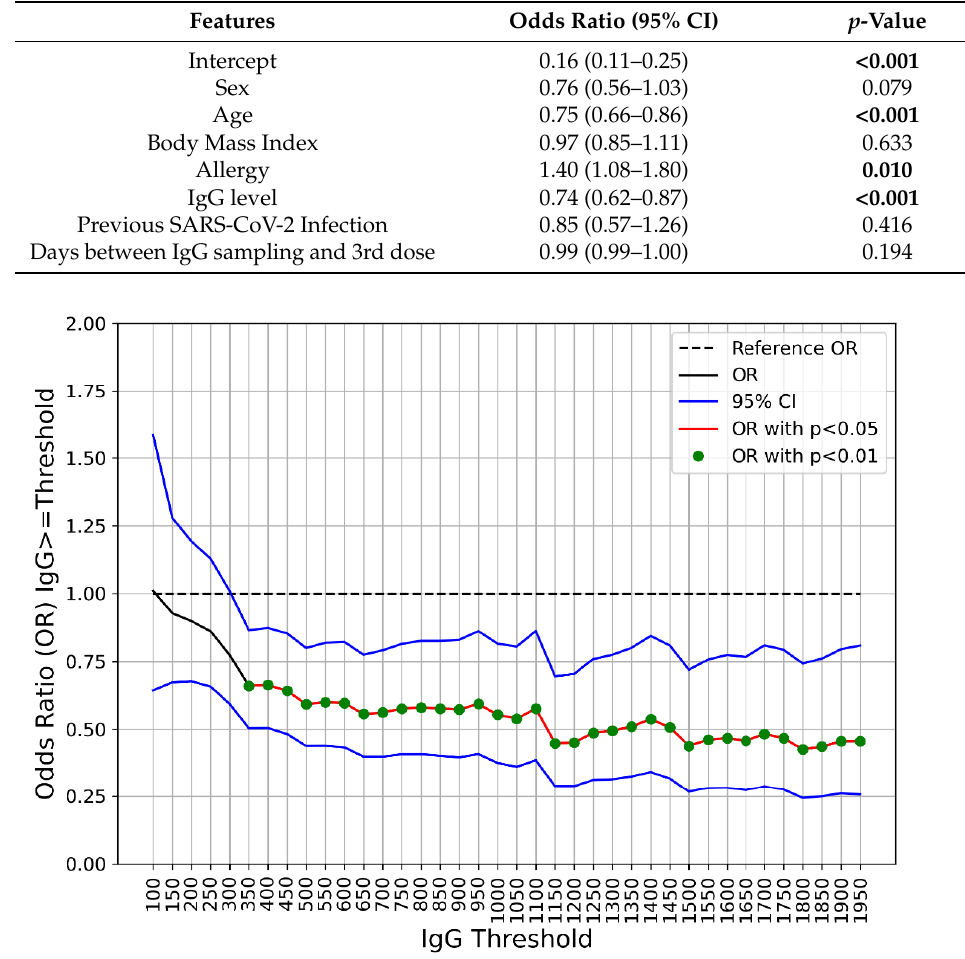
Figure 1. Odds ratios (OR) (black line) and 95% confidence interval (blue lines) obtained while varying the IgG threshold (BAU/mL) and testing its association with an Omicron infection. The red line and green dots represent the odds significantly different from 1 (dashed line), respectively, with p < 0.05 and p < 0.01.